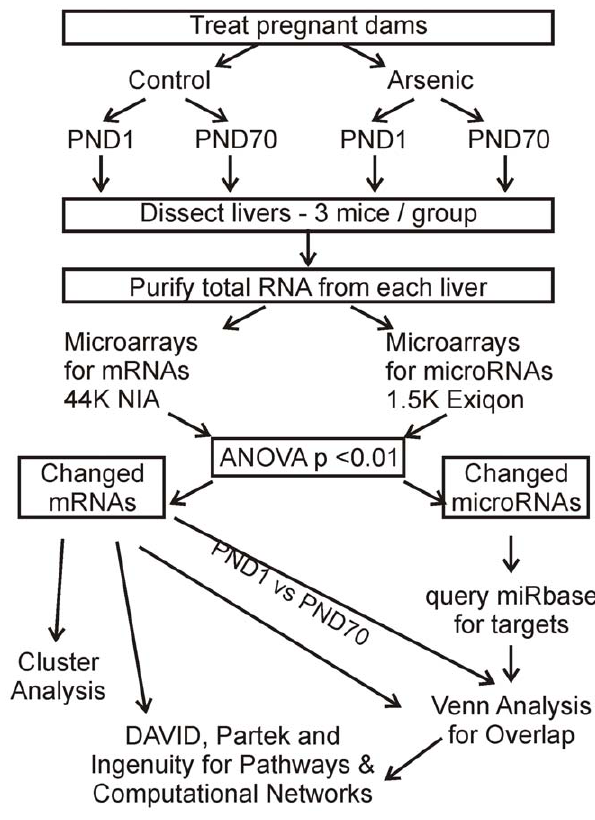
Figure 2. Diagram of experimental design and analytical flow for mRNA and miRNA data.